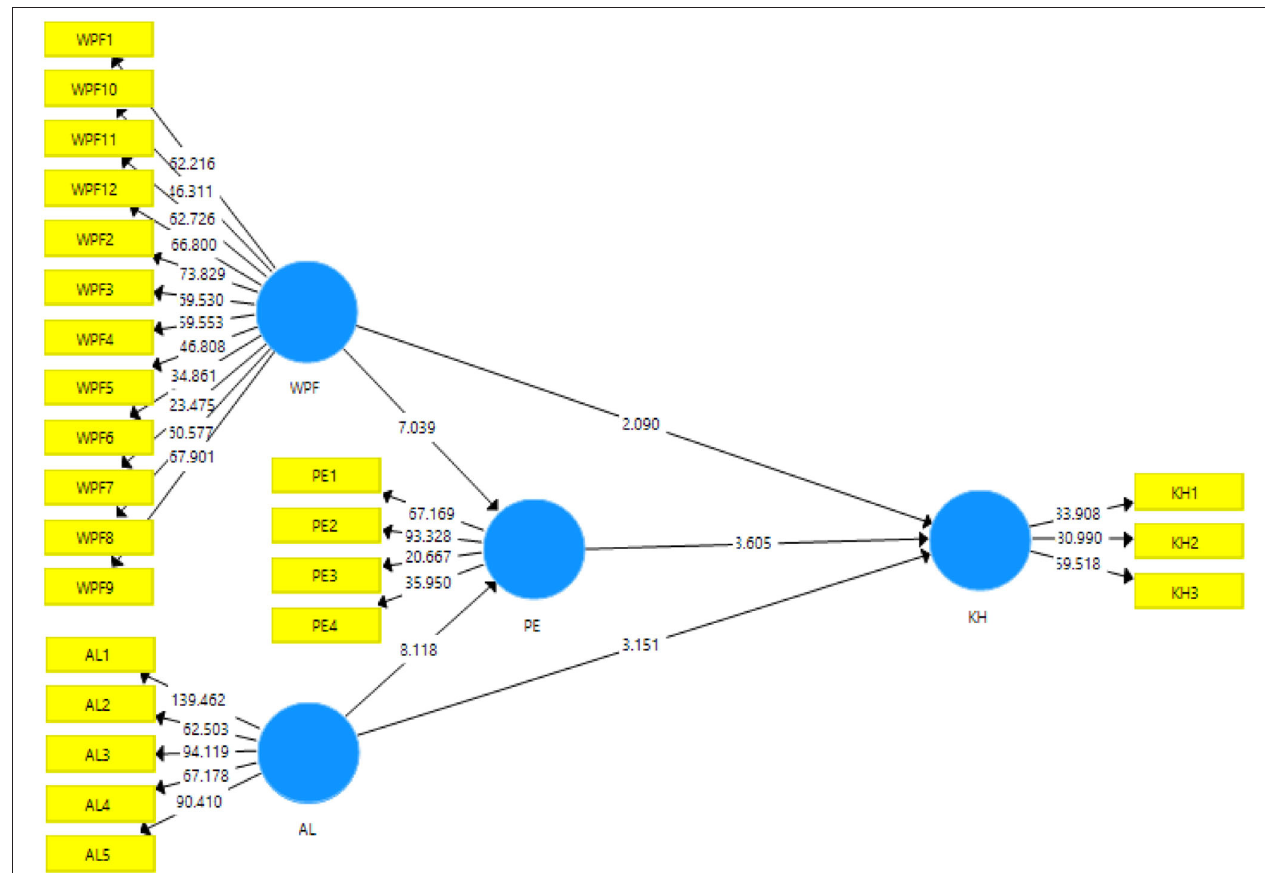
FIGURE 3 | The output of structural model Bootstrapping. WPF, Workplace friendship; AL, Altruistic leadership; PE, Positive emotions; KH, knowledge hiding.